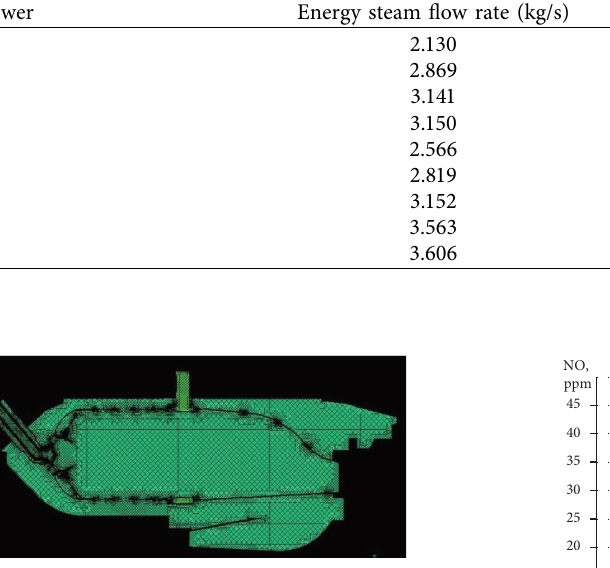
Figure 2: Mesh model of the combustion chamber.